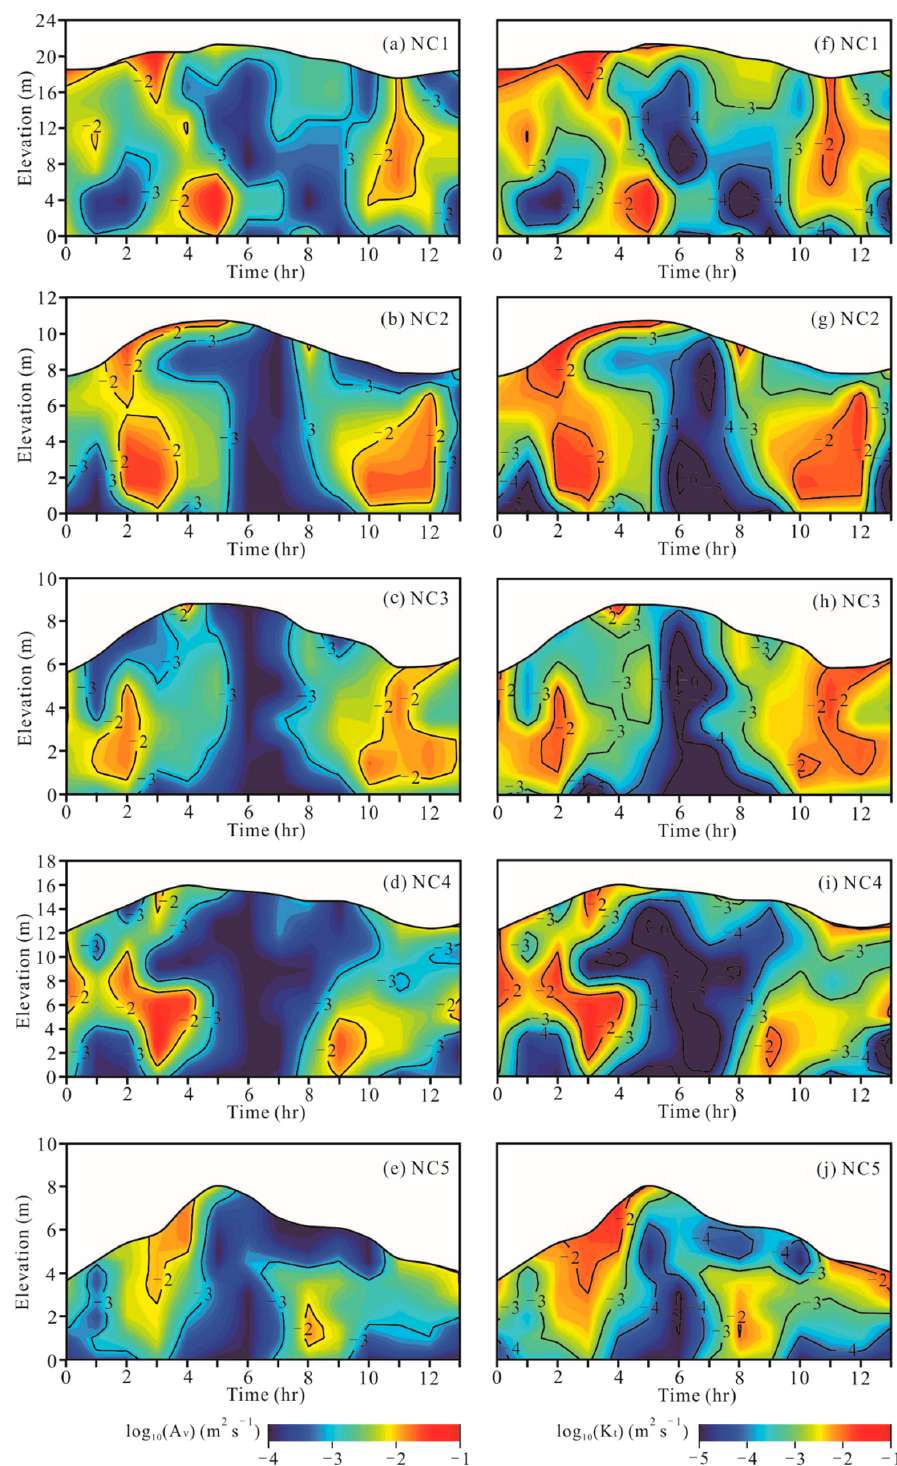
Figure 6. Temporal variations of eddy viscosities, 𝐴 (cid:3049) (m 2 s − 1 ) ( a – e ), and eddy diffusivities, 𝐾 (cid:3047) (m 2 s − 1 ) ( f – j ), at NC1 to NC5 stations. (m 2 s − 1 ) ( f – j ), at NC1 to NC5